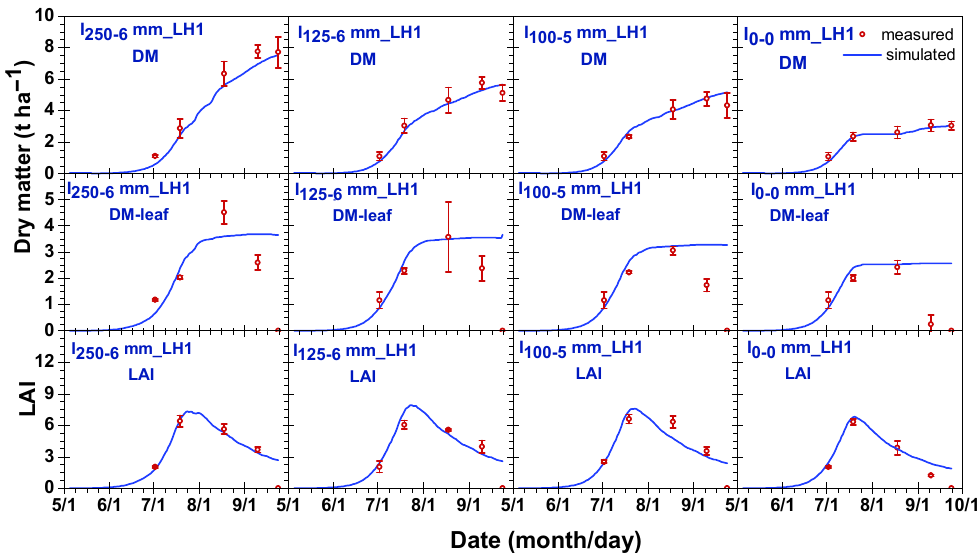
Figure 2. Comparison of measured and simulated values of LAI, DM (the dry matter weight of root, stem and grain) and DM-leaf (the dry matter weight of leaf) under different irrigation schedules of LH1 in 2020.